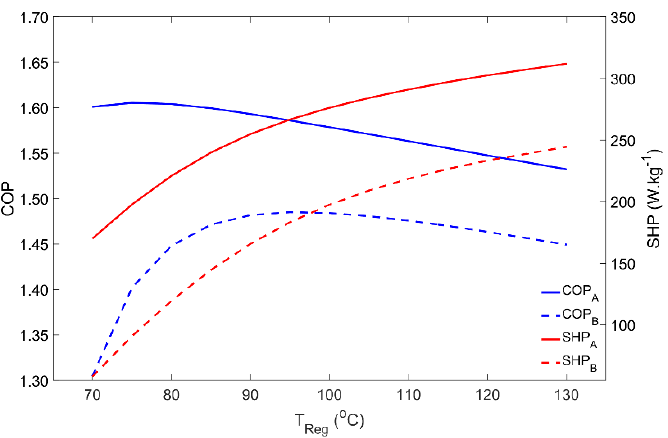
Figure 5. Adsorber performance as a function of the regeneration temperature for scenarios A and